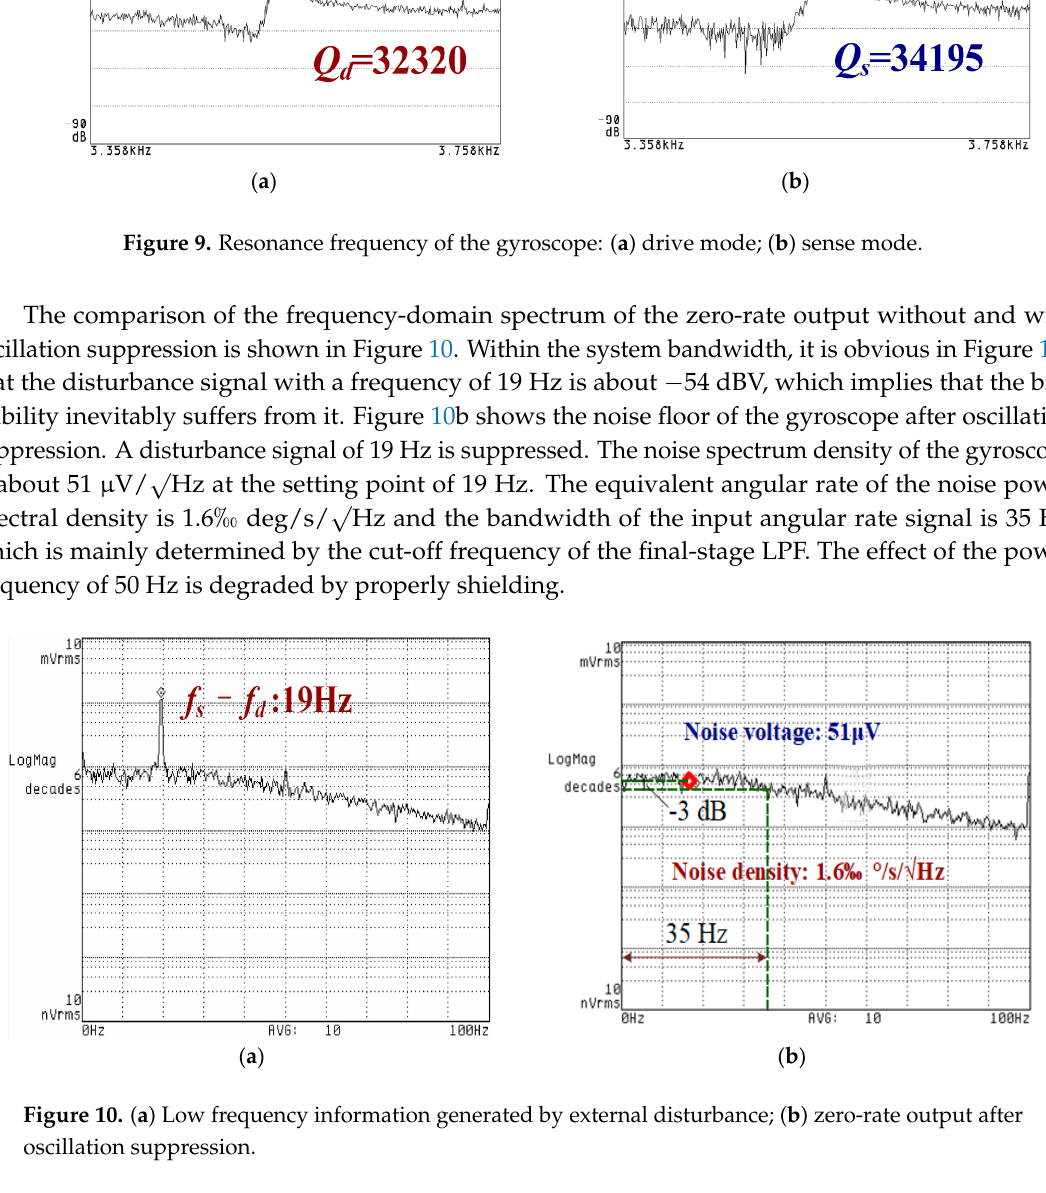
Table 4. Specification of external disturbance.